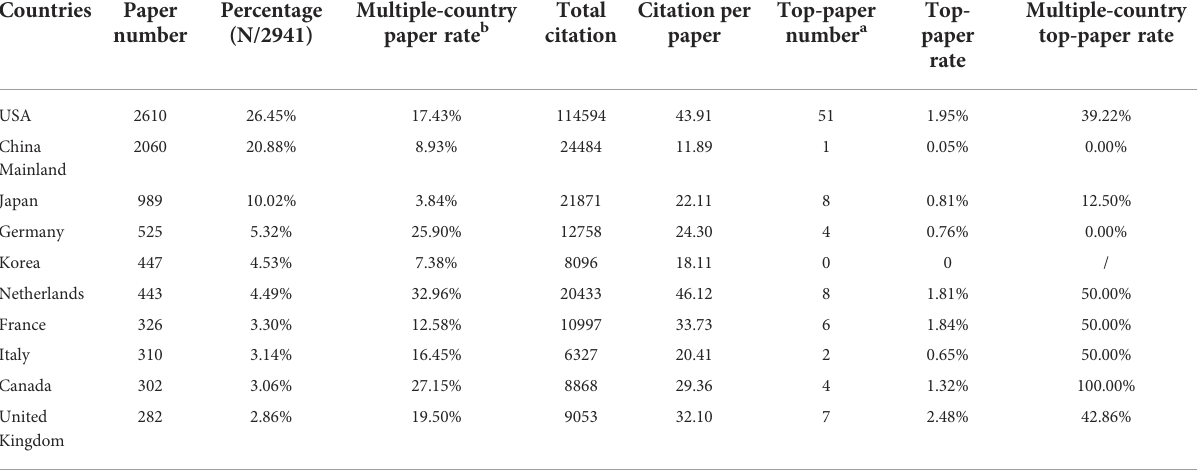
TABLE 4 The top 10 productive countries of corresponding authors of papers in lung cancer radiotherapy from 2000 to 2022. Countries Paper